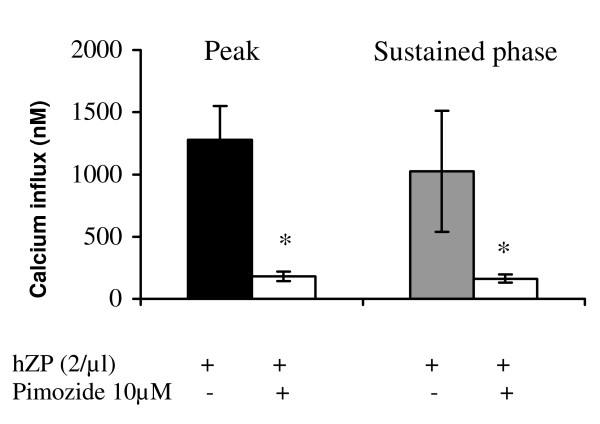
Effects of pimozide on the Ca2+ influx stimulated by hZP. Spermatozoa were capacitated in the presence or absence of 10 μM pimozide. They were then loaded with Fura-2 in BWW medium and hZP (2/μl) was added (n = 3 experiments). The results are expressed as the mean ± SEM of Ca2+ influx induced by hZP, for the peak and the sustained phase; *p < 0.001, Mann and Whitney test.